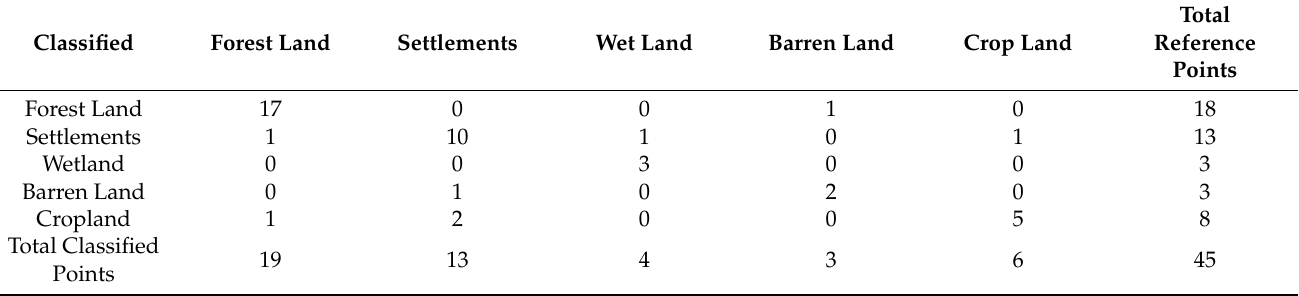
Table 4. Error matrix of 5 classes of